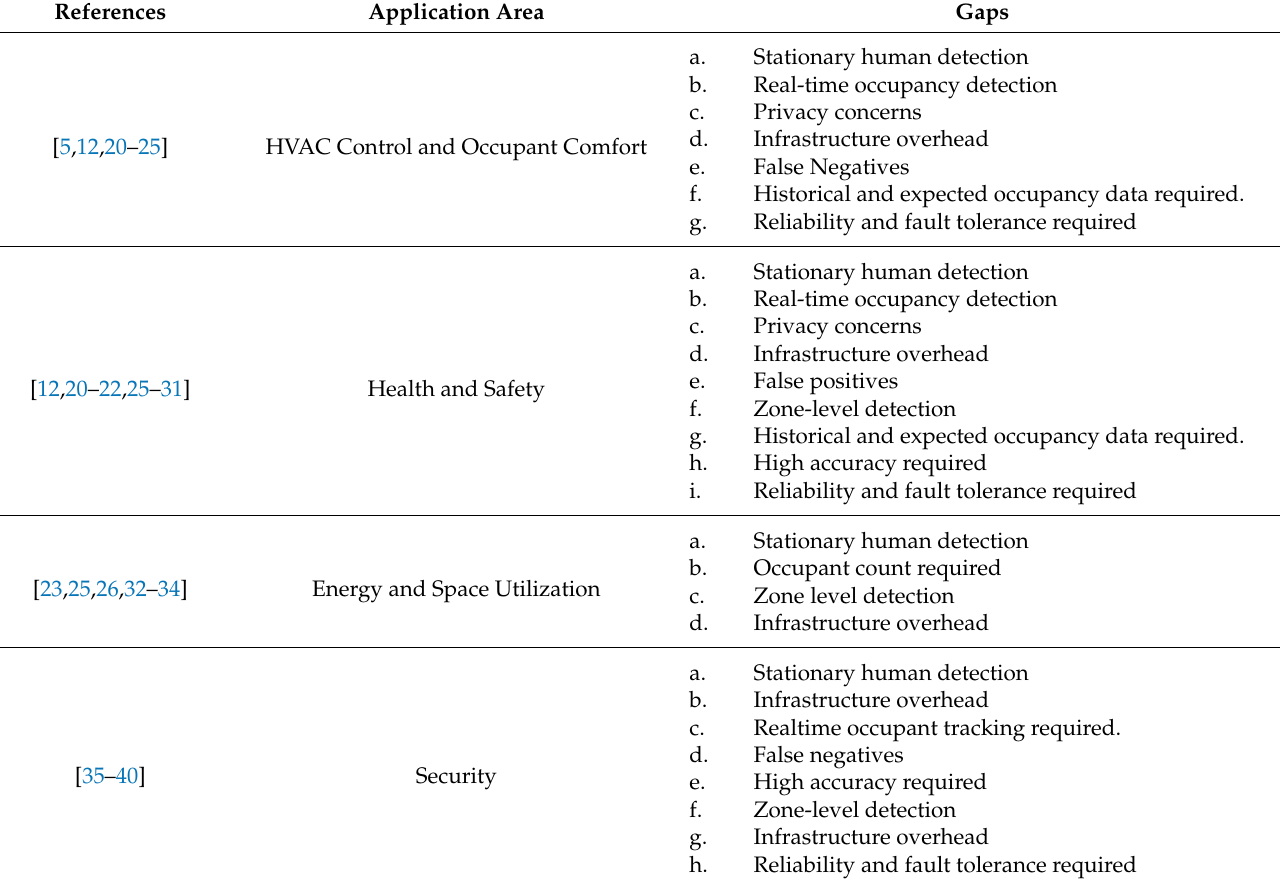
Table 2. Occupancy sensing gaps for Networked Sensor Nodes-Based Estimation